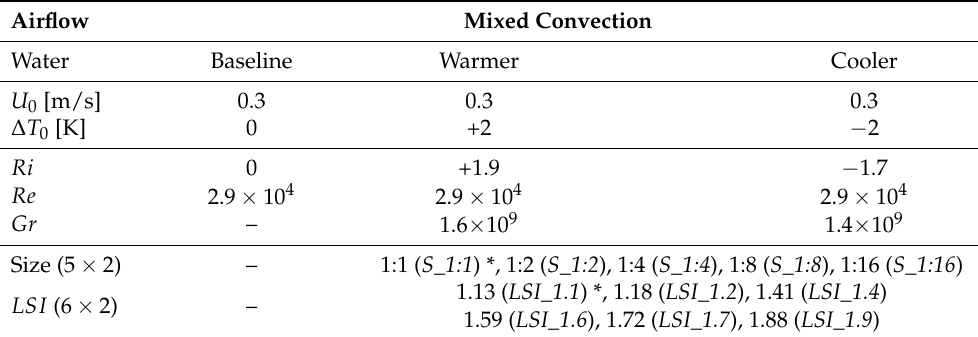
Table 1. Configuration settings and simulation outline for the simulations under consideration: char- simulations conducted for different sizes and shapes including simulation labels. For the definitions of the Richardson ( Ri ) and Grashof ( Gr ) numbers, the reader is referred to Ampatzidis et al. [22]. Airflow Mixed Convection Water Baseline Warmer Cooler